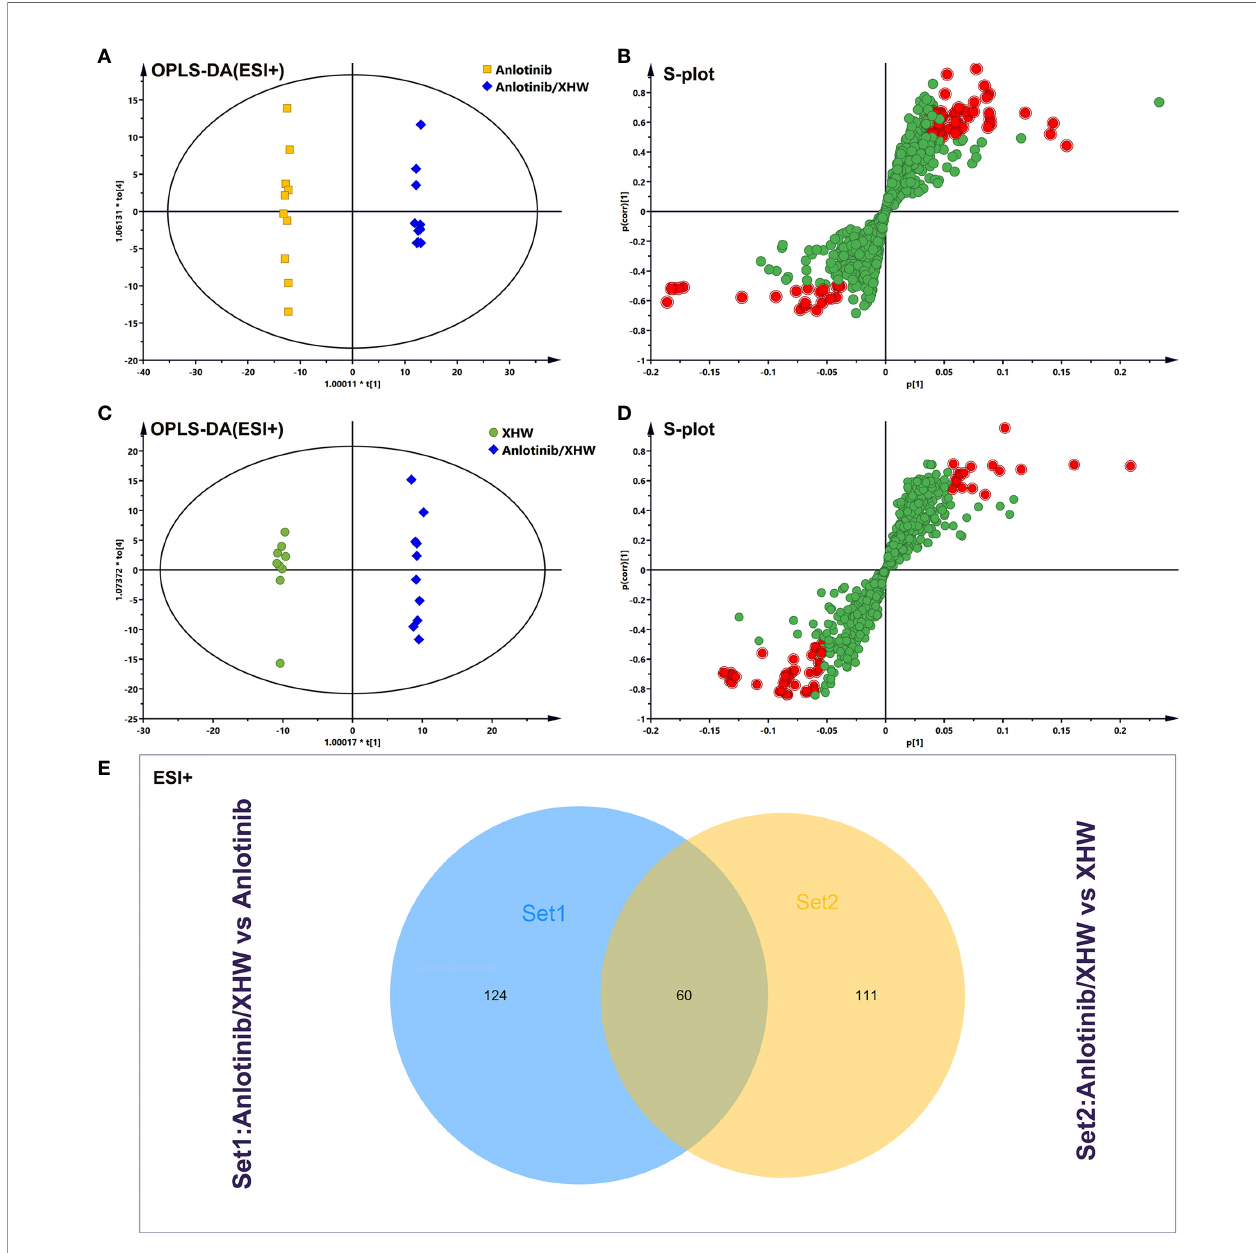
FIGURE 4 | Analysis of potential biomarkers associated with anlotinib plus XHW in the treatment of lung cancer in ESI+ mode. (A) Results of the OPLS-DA model using the data from the anlotinib/XHW group vs the anlotinib group. (B) S-score plot constructed from the supervised OPLS analysis of the anlotinib/XHW group vs the anlotinib group. (C) Results of the OPLS-DA model using the data from the anlotinib/XHW group vs the XHW group. (D) S-score plot constructed from the supervised OPLS analysis of the anlotinib/XHW group vs the XHW group. Metabolite ions with variable in fl uence on the projection (VIP) values >1 and |p(corr)| ≥ 0.5 are marked with a red square. The x-axis represents the co-correlation coef fi cient between the principal component and the metabolite, and the y-axis represents the correlation coef fi cient between the principal component and the metabolite. (E) Venn diagram of metabolites showing the overlap between the anlotinib/XHW, anlotinib, and XHW